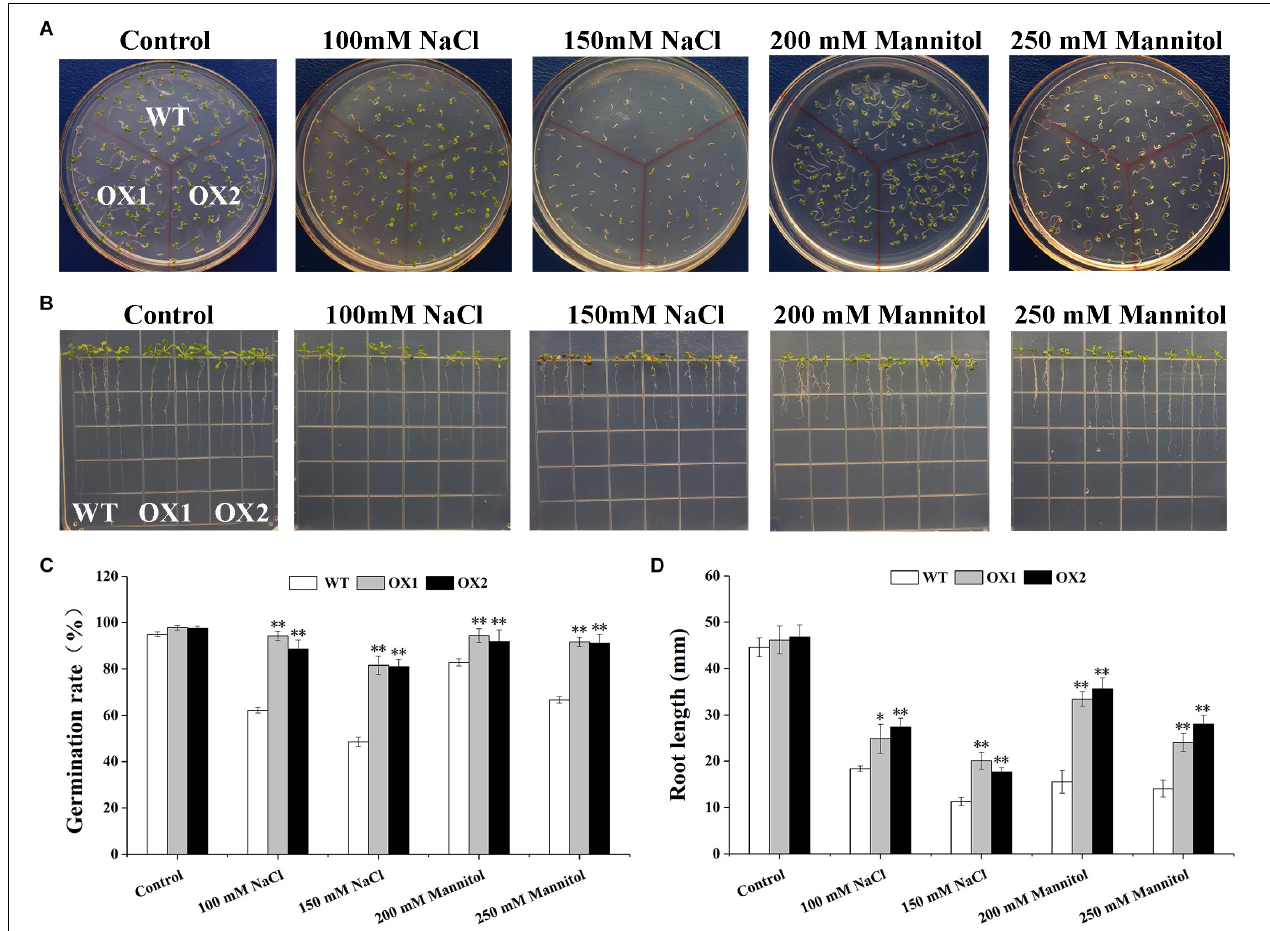
FIGURE 5 | Comparison of the germination rate and root length between OoNAC72 -OX and WT Arabidopsis plants. (A) Seed germination assay between OoNAC72 -OX and WT Arabidopsis plants. The surface-sterilized seeds were sowed on 1/2 MS solid medium supplemented with 100 mM NaCl, 150 mM NaCl, 200 mM mannitol and 250 mM mannitol incubated at 22 ◦ C. (B) Root length assay between OoNAC72 -OX and WT Arabidopsis plants. Five-day-old seedlings were cultured vertically on 1/2 MS solid medium supplemented with 100 mM NaCl, 150 mM NaCl, 200 mM mannitol and 250 mM mannitol for 7 days. (C,D) Effects of salt and drought stress treatments on germination rate and root length. Data are represented as mean ± SD of at least three independent replications. Asterisk indicates significant difference ( ∗ P < 0.05; ∗∗ P < 0.01) between transgenic lines and